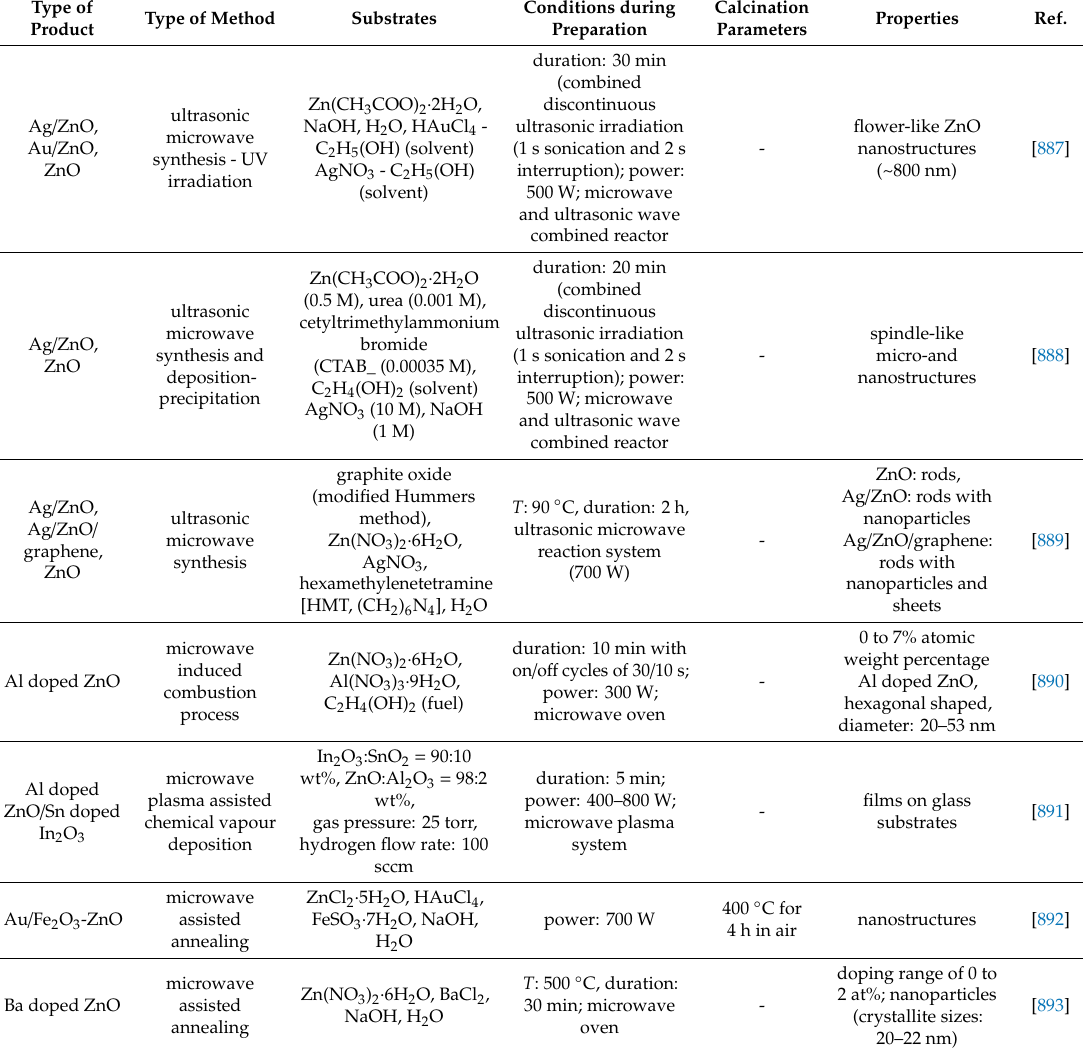
Table 14. Summary of the microwave hybrid synthesis method of ZnO nanocomposites or ZnO hybrid